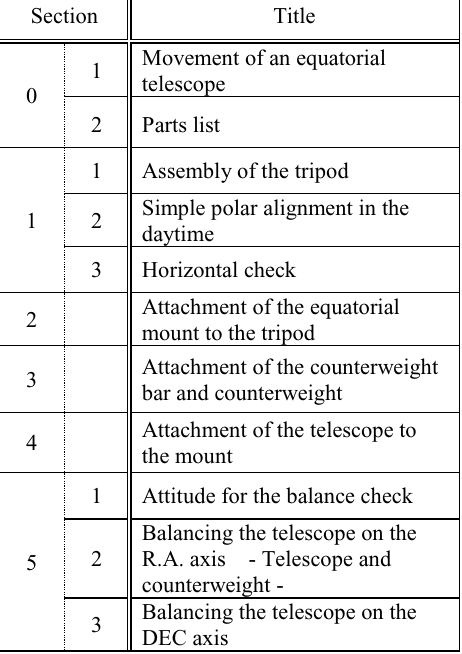
Figure 1. Unsafe attachment of counterweight